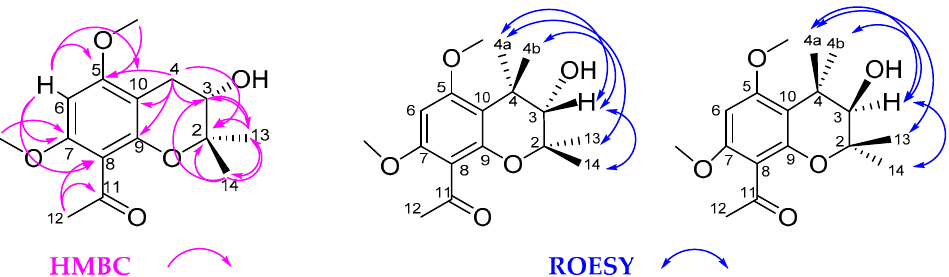
Figure 5. Key correlations of the racemic 4 in the HMBC and ROESY spectra.